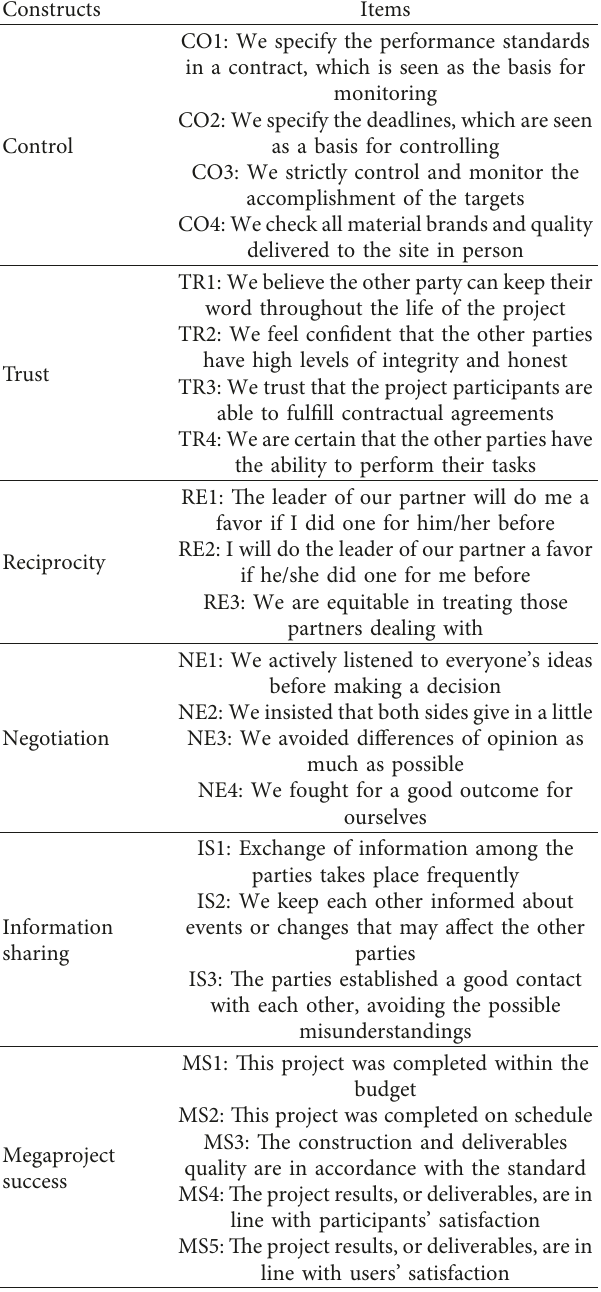
Table 3: Measurement reliability and convergent validity assessment.